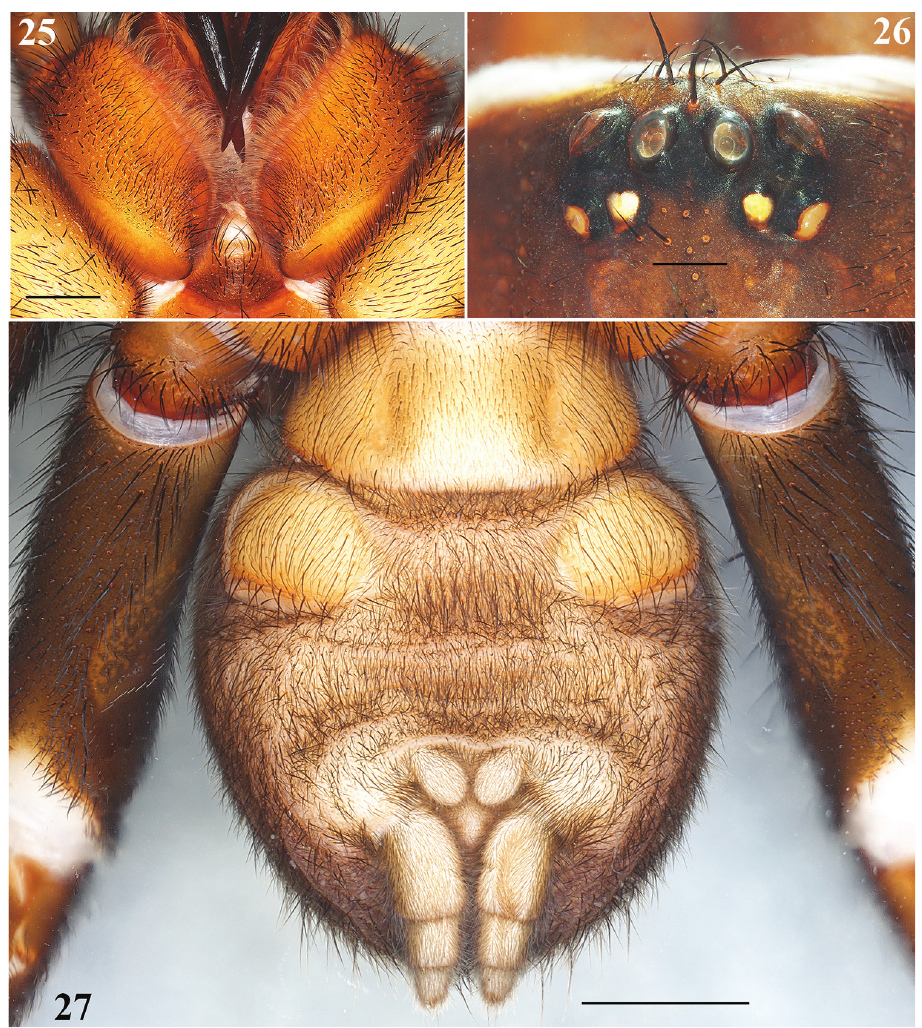
Figures 25–27. Eucteniza zapatista Bond & Godwin, 2013. Male: 25 Labium and endites, ventral view 26 Ocular region 27 Opisthosoma, ventral view, showing spinnerets. Scale bars 0.5 mm ( 26 ), 1 mm ( 25 ), 2 mm ( 27